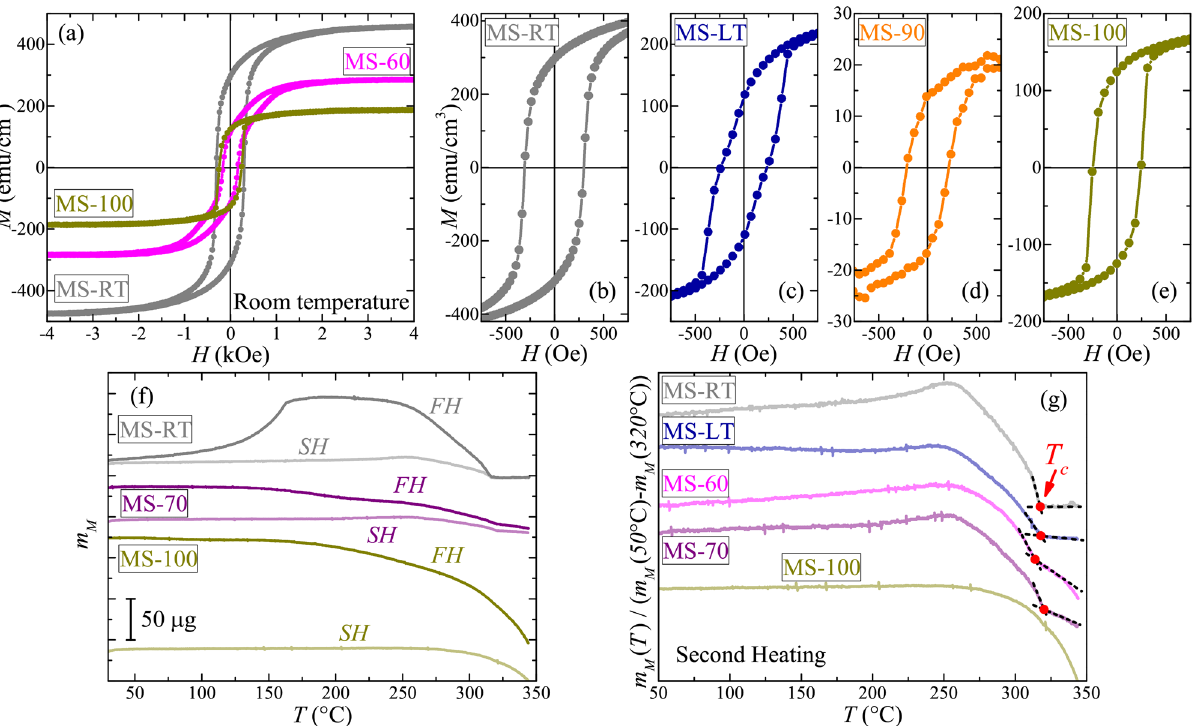
Figure 5. Room temperature ( a ) full magnetization curves and ( b – e ) low field regions of corresponding curves for several studied samples. ( f ) TGA curves measured with attached external magnet (at a heating rate of 10 ◦ C/min). FH—first heating, SH—second heating. The curves are vertically shifted (in pairs) for clarity. ( g ) Normalized TGA curves measured with attached external magnet during the second heating. The curves are vertically shifted for clarity. Estimated T c values are marked by red